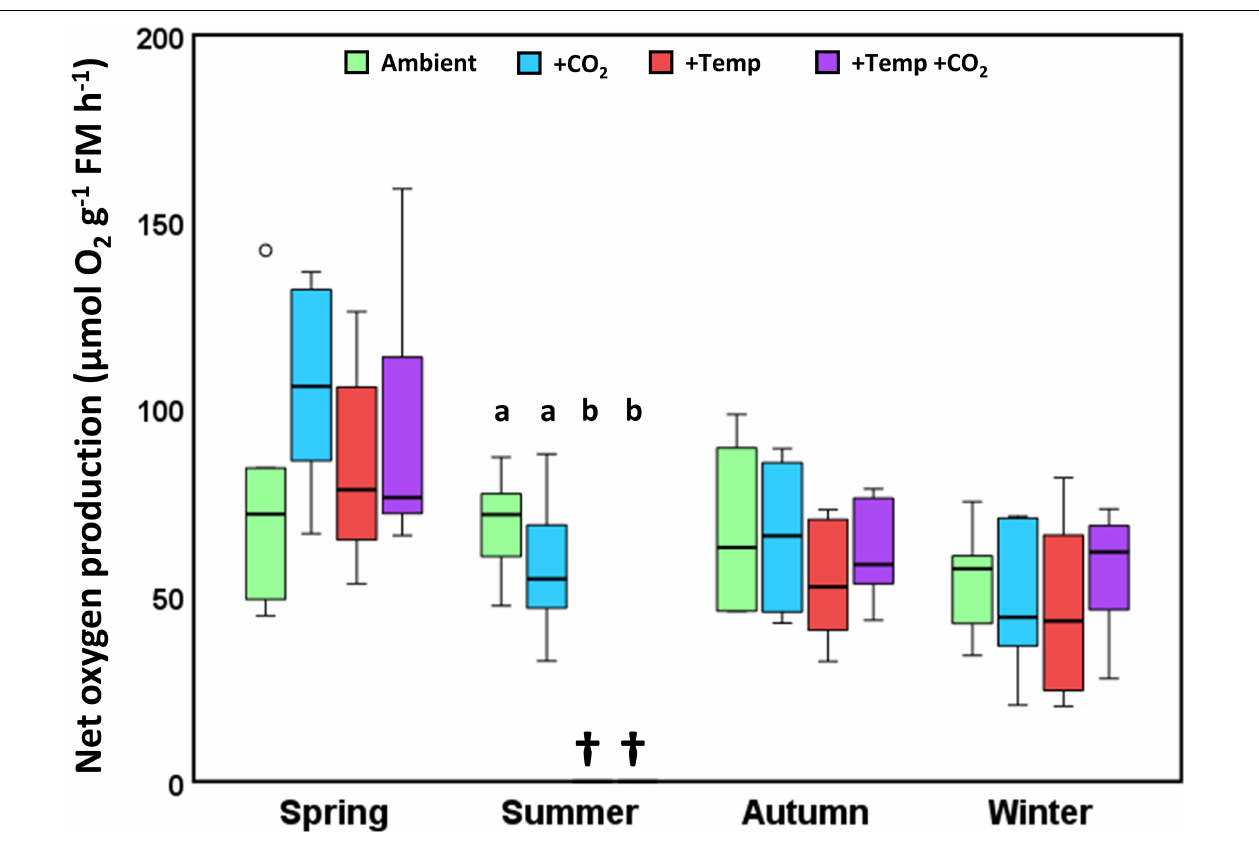
FIGURE 4 | Net oxygen production of Fucus vesiculosus individuals at the end of the experiments in the Kiel Outdoor Benthocosms (KOBs), with various temperature and pCO 2 conditions over different seasons. Experimental individuals were measured at 15 ◦ C and 200 µ mol photons m − 2 s − 1 after 3 months of incubation in the KOBs. Seasons: spring: April 4–June 19, 2013; summer: July 4–September 17, 2013; autumn: October 10–December 18, 2013; winter: January 16–April 1, 2014. Temperature and pCO 2 conditions: Ambient: ambient temperature and pCO 2 , +CO 2 : ambient temperature and elevated pCO 2 , +Temp: elevated temperature and ambient pCO 2 , +Temp +CO 2 : elevated temperature and pCO 2 ( n = 3). Different lowercase letters indicate significant differences ( p < 0.05; Tukey’s test). Horizontal lines represent the median; boxes, the interquartile range; whiskers, 1.5 × of inter-quartile range; circle, the outlier. Cross ( † ) indicates dieback of F. vesiculosus in the summer experiment under